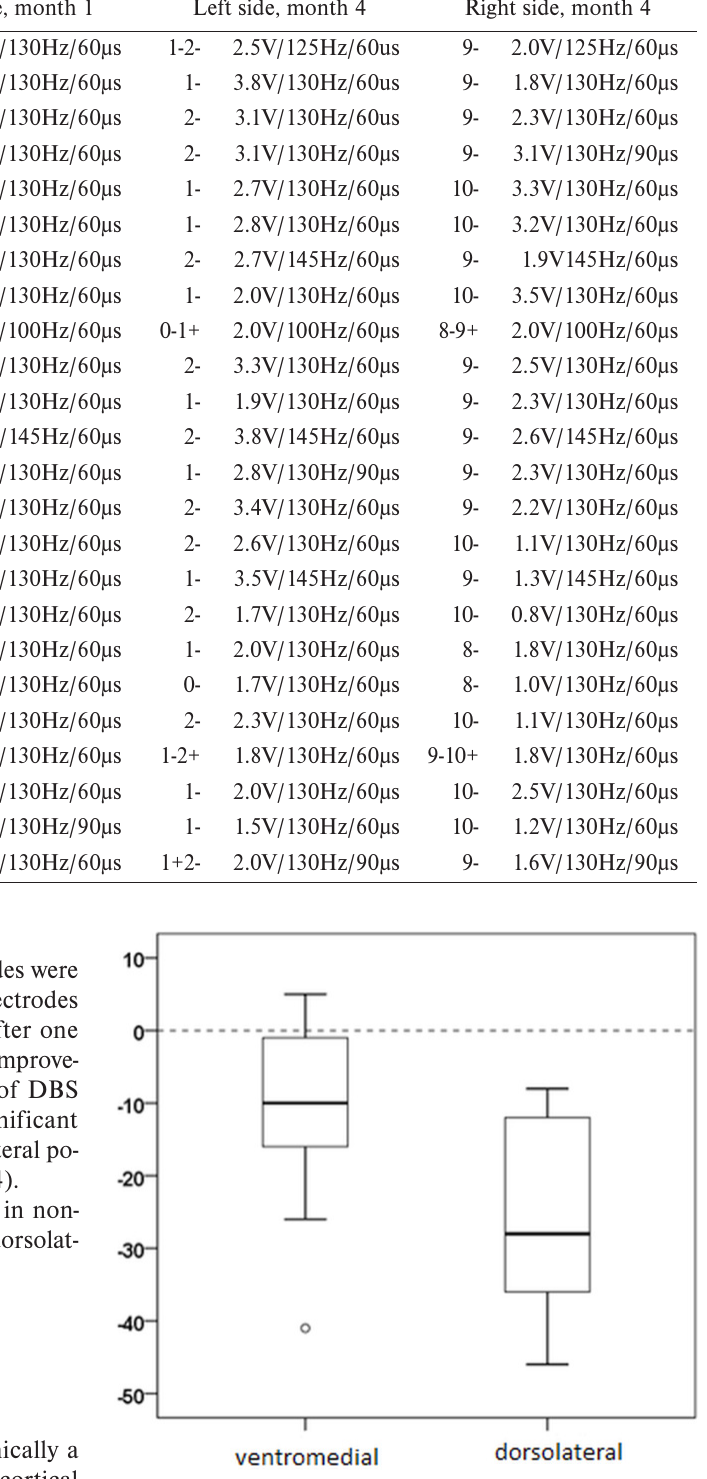
Fig. 4. Change in NMSS after 1 month – left side, division into two